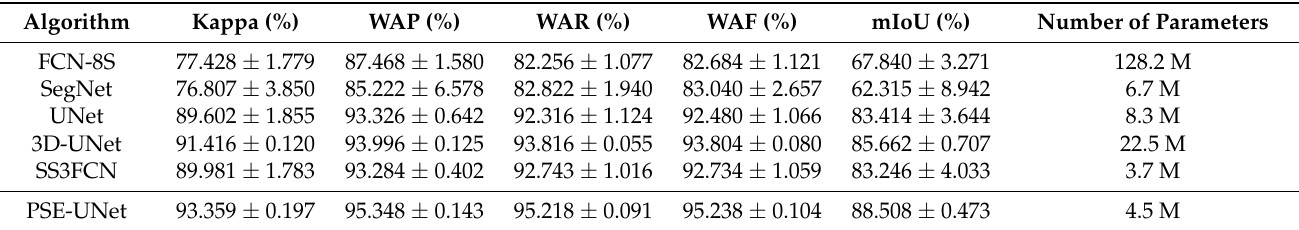
Table 3. Comparison of accuracy of different algorithms.